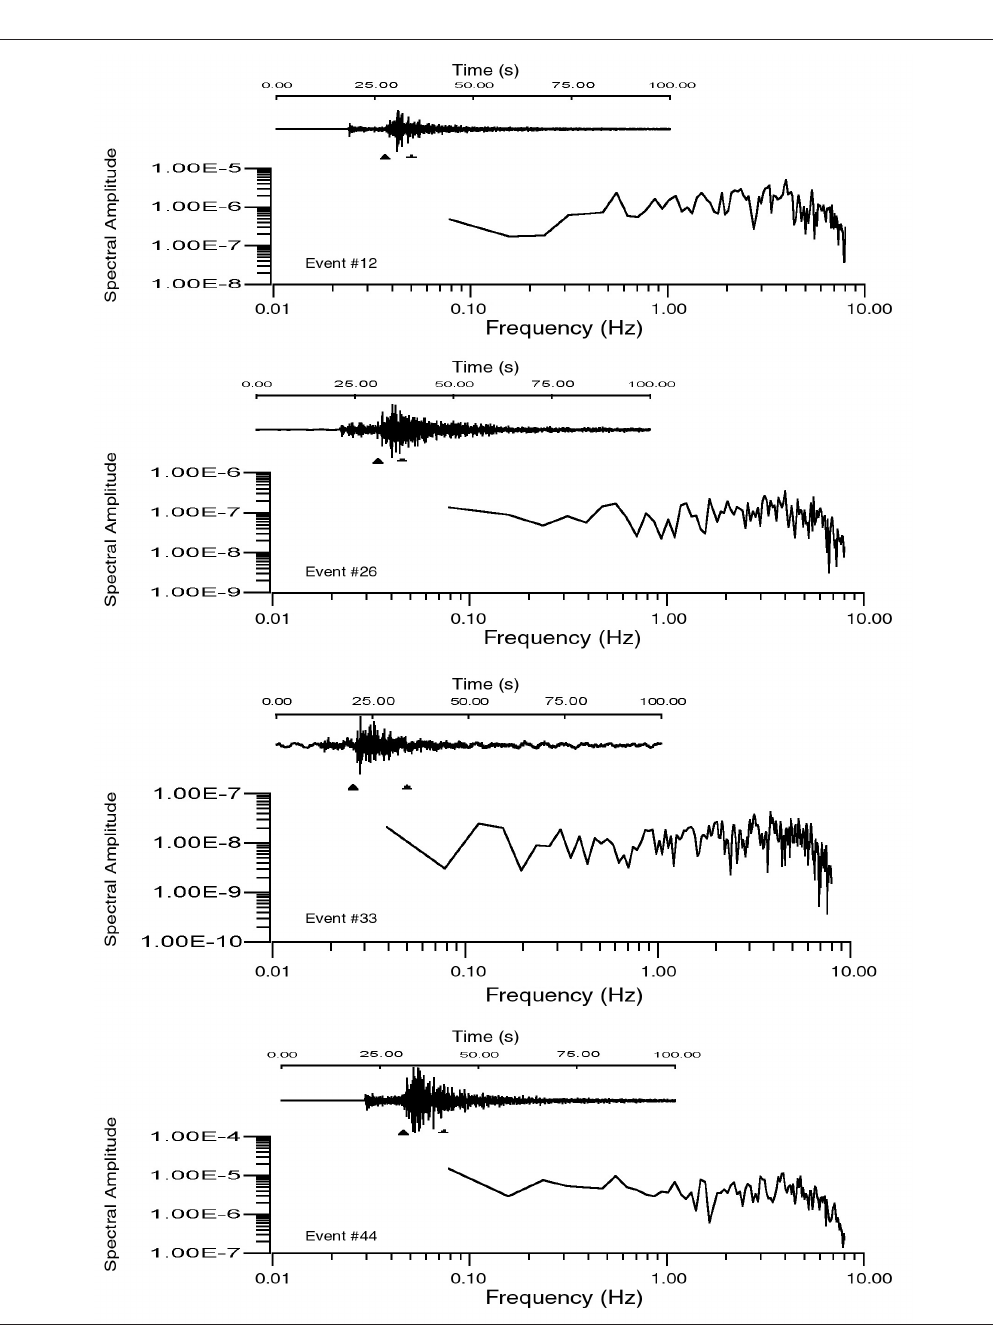
Fig. 2. Displacement spectra for L g -waves for some selected